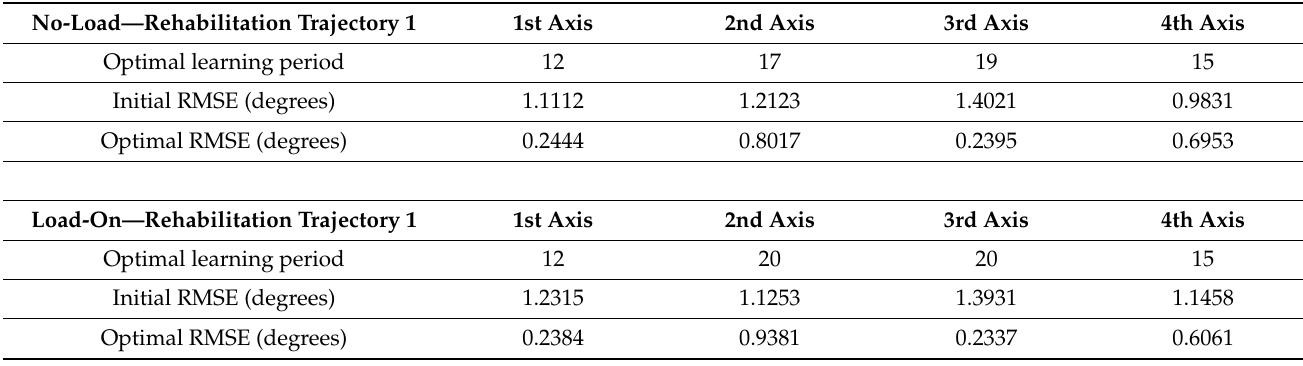
Figure 26. Trajectory 1—4th-axis (load-on) ILC trial 1 and trial 15 tracking and error diagrams. The above experimental results were compiled as shown in Table 10. From Table 10, Table 9. Trajectory 1 (load-on) ILC controller parameters table. it is observed that for the first axis, before learning control, the angle RMSE increased by 0.1203 ◦ after adding the load, and for the second axis, the angle RMSE decreased by 0.087 ◦ after adding the load. After adding the load, the trajectory of all axes of the robot arm is slightly affected, but the overall trajectory performance still maintains a certain degree of accuracy, and the trajectory results of all axes are significantly improved after applying ILC. Table 10. Trajectory 1—before and after applying ILC—table comparing the tracking results of each axis with and without loading